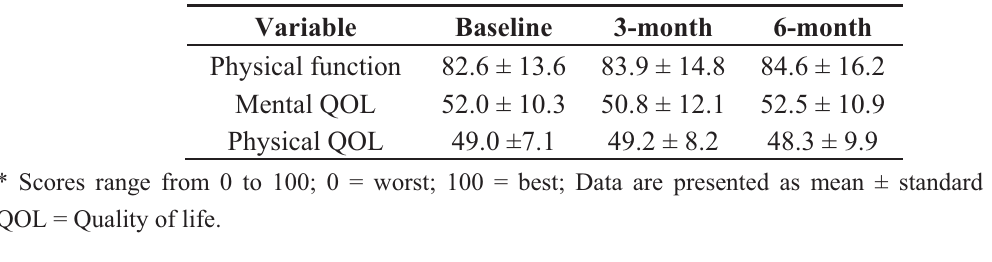
Table 5. Comparison of Short Form (36) Health Survey * ( N =